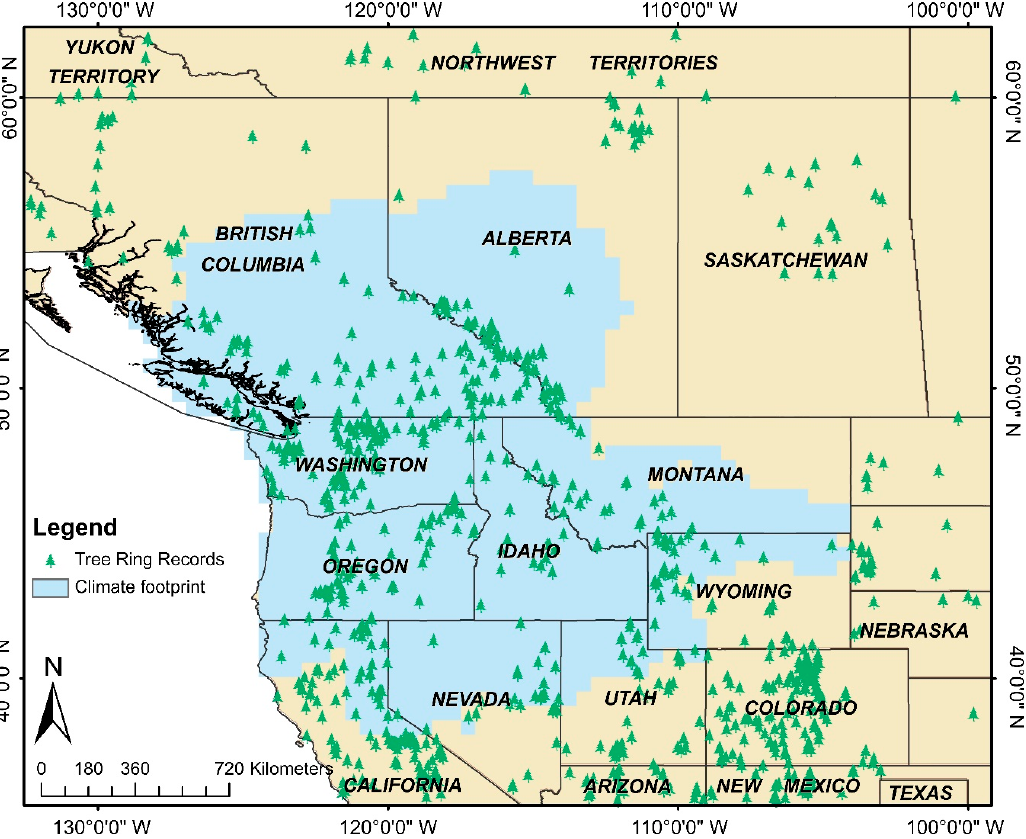
Figure 3. Climate footprint for the BC Interior showing the spatial extent of significant correlation ( p < 0.10) between average depth to groundwater levels and gridded 12-month Standardized Precipitation Evaporation Index (SPEI) (Koninklijk Nederlands Meteorologisch Instituut (KNMI) Climate Explorer).